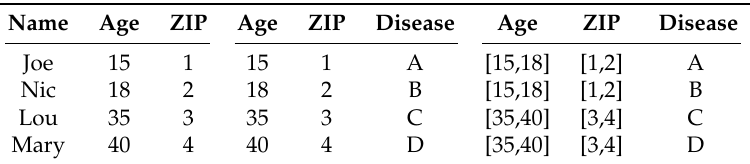
Table 1. On the right, the adversary’s knowledge; in the center, the original medical records; on the left, a 2-anonymous